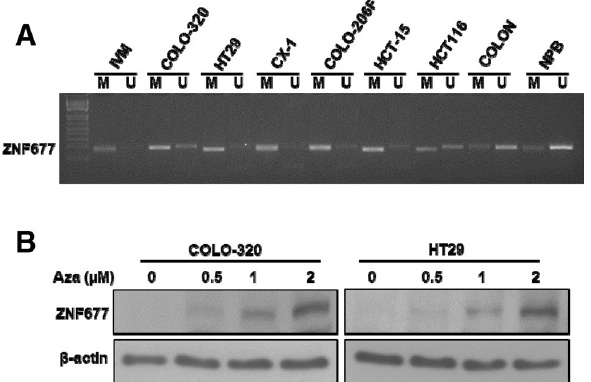
Figure 5. Loss of ZNF677 protein expression is associated with ZNF677 promoter methylation. ( A ) Methylation status of CRC cell lines were assessed by methylation-specific PCR for the ZNF677 gene. MSP analyses of both methylated (M) and unmethylated (U) reactions were amplified from bisulfite-treated DNA and run in a 2% agarose gel. ( B ) Demethylation of the ZNF677 gene restored ZNF677 expression in COLO-320 and HT29 cells. COLO-320 and HT29 cell lines were treated with different doses (0.5, 1, and 2 µM) of 5-aza- 2 ′ deoxycytidine for 72 h before lysis. Equal amounts of proteins were immunoblotted with antibodies against ZNF677 and